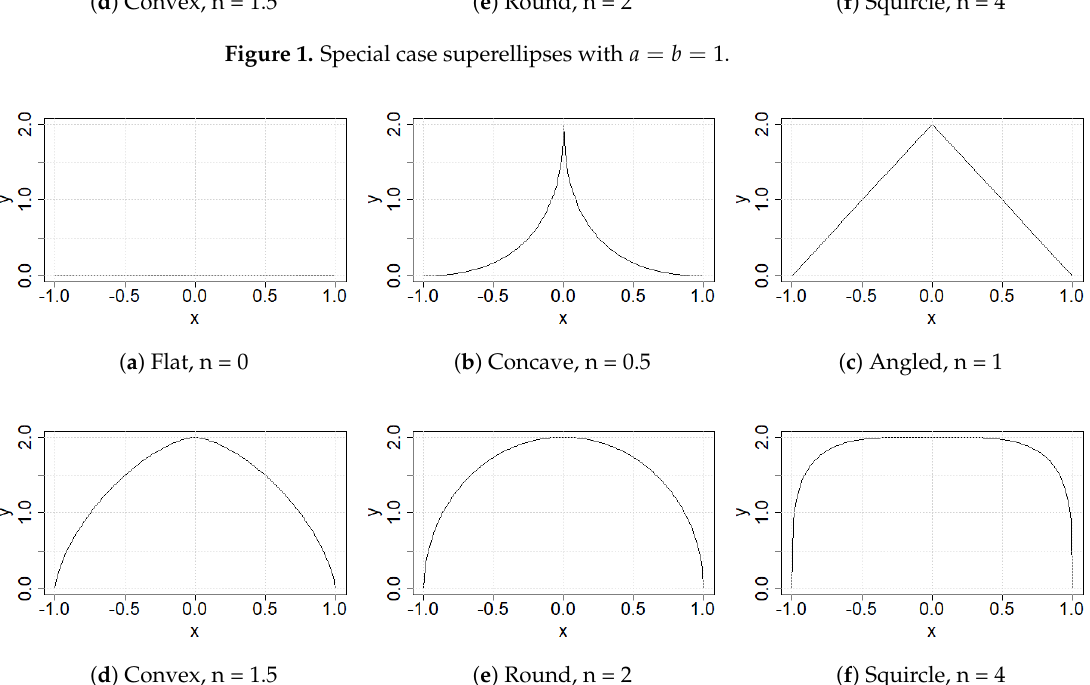
Figure 2. Special case superellipses with a = 1, b =